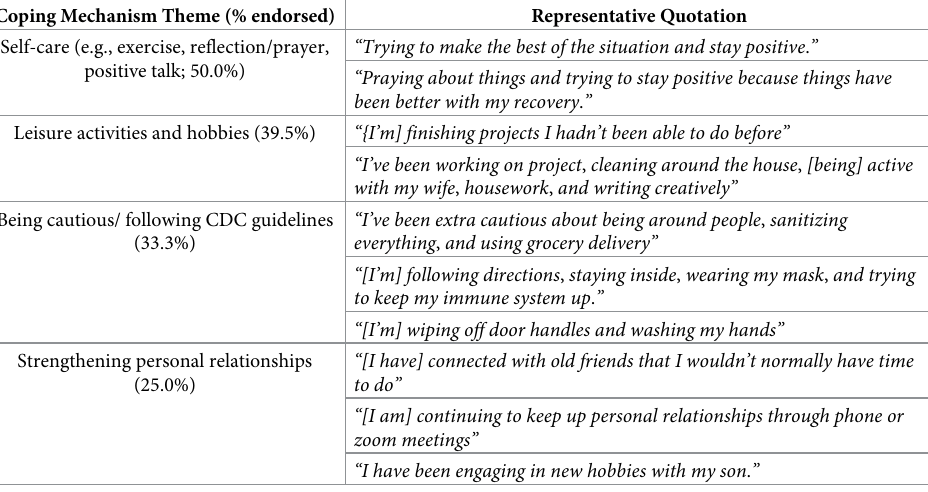
Table 5. Themes of coping strategies that facilitate recovery with representative quotations. Coping Mechanism Theme (% endorsed)